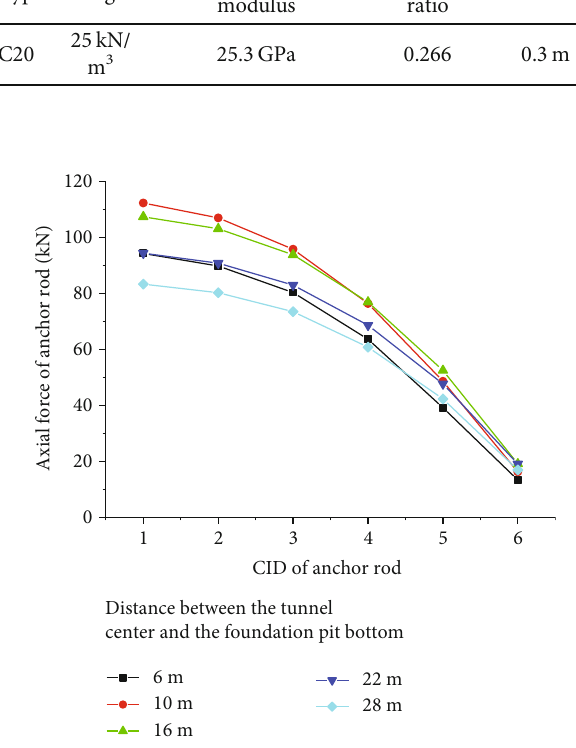
Figure 4: Axial force of anchor rod at di ff erent distances from the top of tunnel under foundation pit.